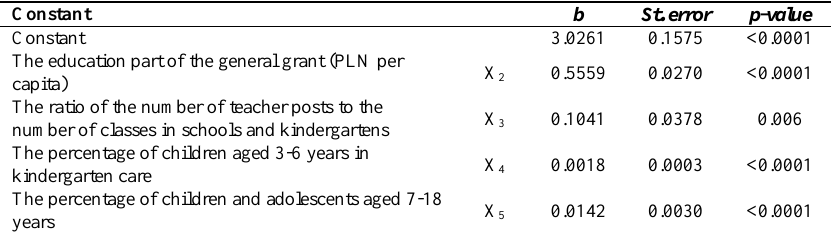
Table 5. The regression results for education expenditures in municipalities with the lowest own revenue in 2016